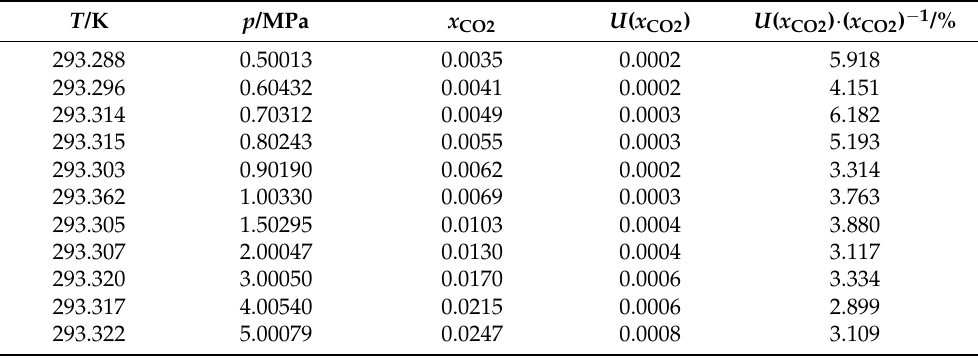
Table A2. Experimental results for solubility measurements of pure carbon dioxide in water at T = 293.15 K using Raman spectroscopy. Recorded temperature (ITS-90), pressure, mol fraction, and estimated uncertainties ( k = 2) are listed in the